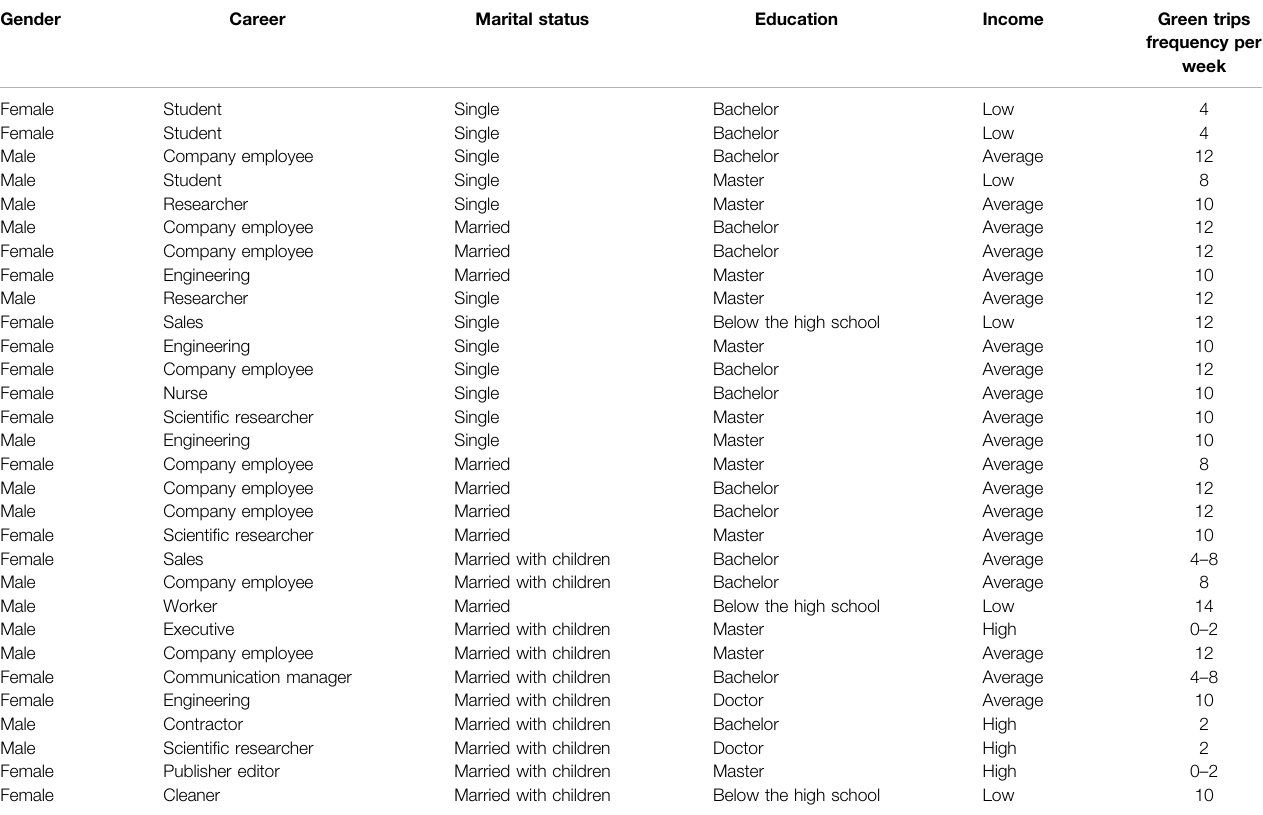
TABLE 1 | Pro fi les of participants.